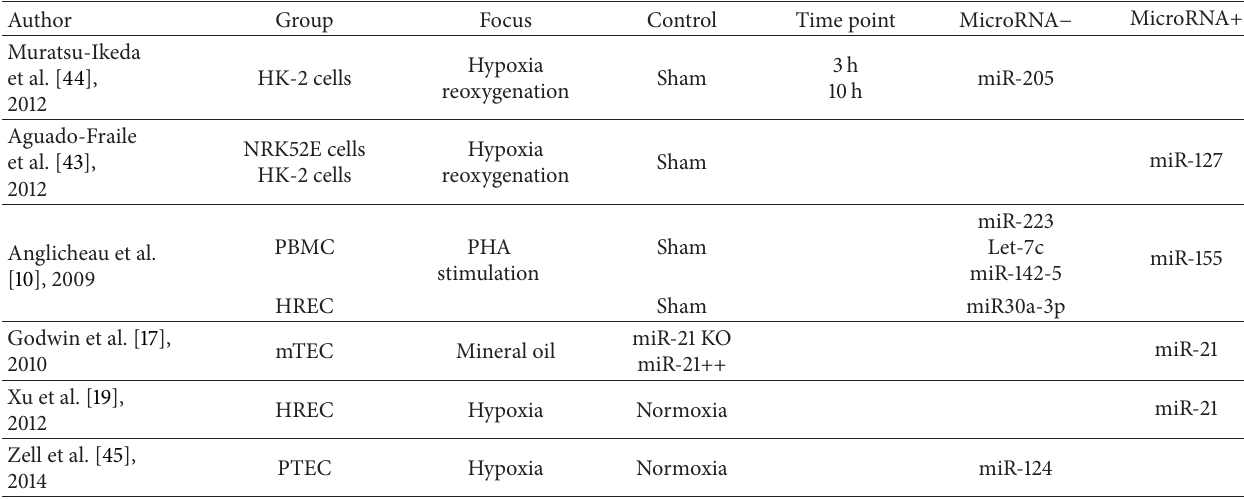
Table 3: Overview of in vitro experiments. PBMC = peripheral blood mononuclear cells. HREC = human renal epithelial cells. PTEC = proximal tubular epithelial cells. mTEC = murine tubular epithelial